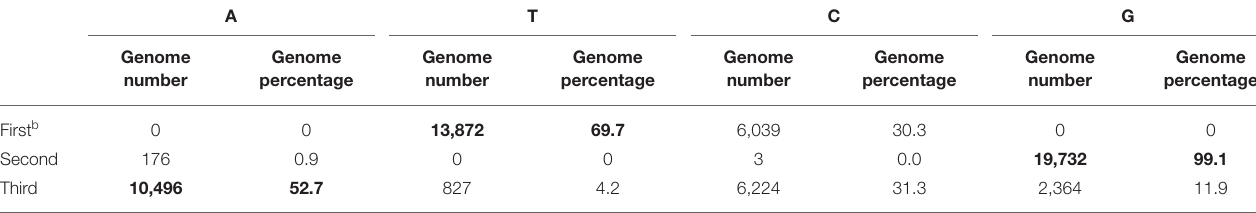
TABLE 1 | Number and percentage of bacterial genomes with each nucleotide showing the least at each codon position a . A T C G Genome Genome Genome Genome number percentage number